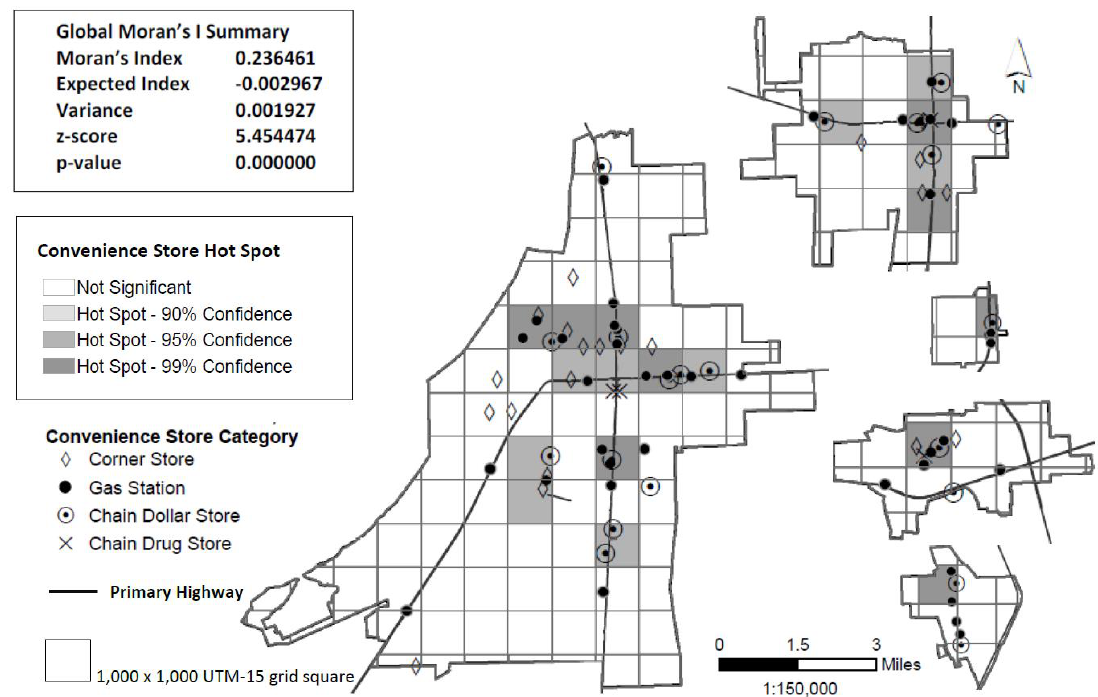
Figure 1. Spatial distribution and clustering (hot spots) of convenience stores in five rural Lower Mississippi Delta towns.